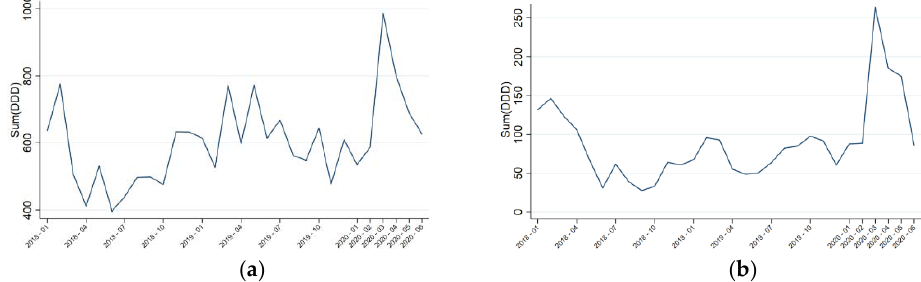
Figure 3. Evolution of global antimicrobial consumption expressed in defined daily doses (DDD)/100 bed-days. ( a ) Hospital: β-change 124.242, p = 0.106; ( b ) extended-intensive care unit (ICU): β-change 97.960, p = 0.001.